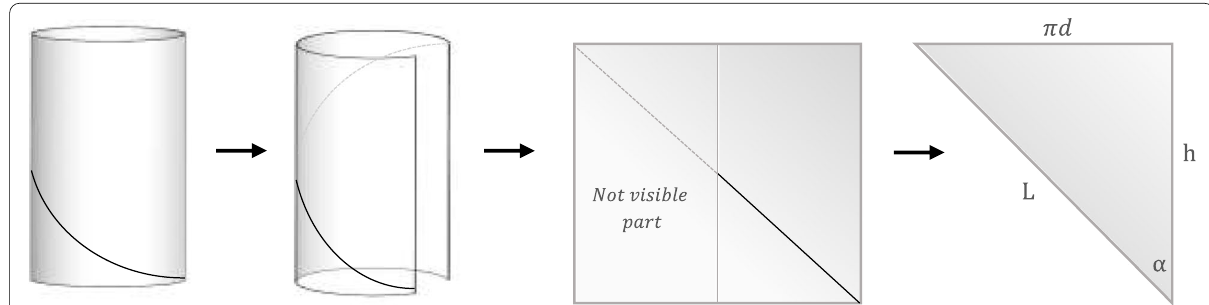
Fig. 17 Geometric relation of a